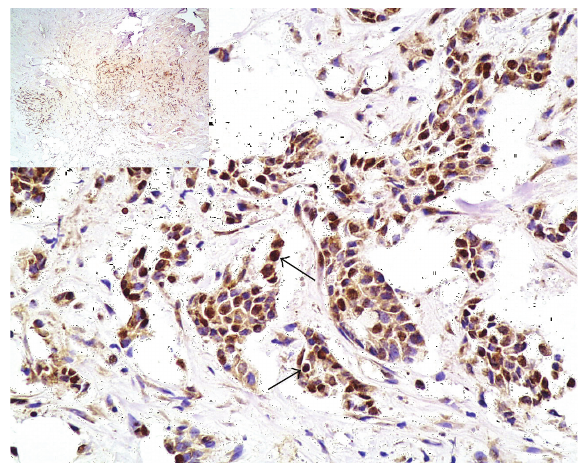
Figure 3: Occurrence of NUCKS in invasive ductal carcinoma, G III. The positive reaction was found in majority of tumor cells with prevalence of nuclear staining (arrows and brown color). The nuclei negative for NUCKS are stained blue or dark blue. ABC method. Magnification 200x, inset 40x.